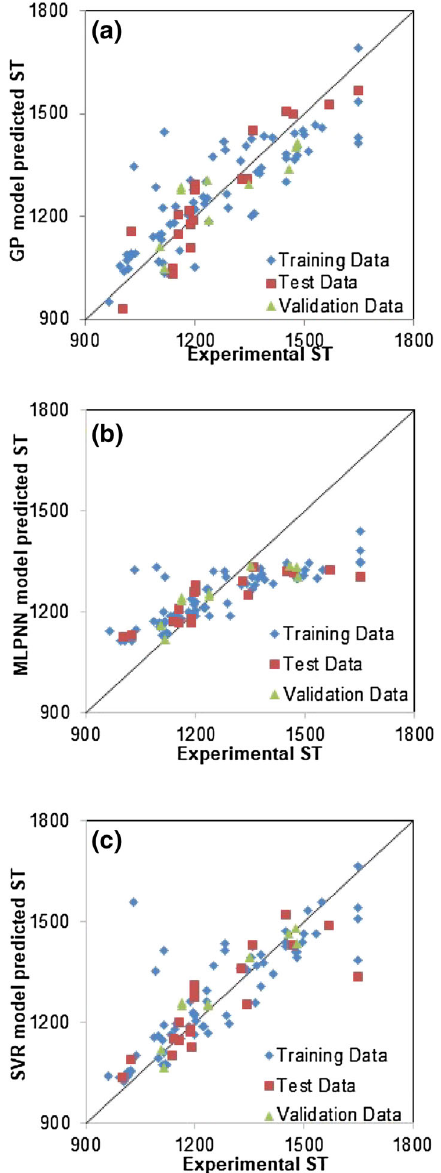
Fig. 10 Plots of experimental HT values versus those predicted by the GP (panel a ), MLP (panel b ), and SVR based (panel c )